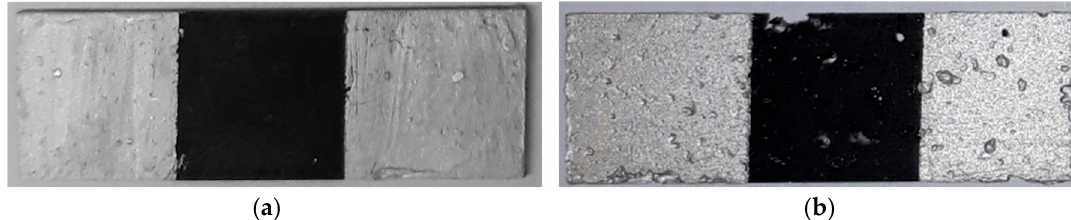
Figure 7. Composite specimens (30 mm × 10 mm × 0.5 mm), partially covered with silver paste; ( a ) Ep/MWCNT-10% (undoped MWCNTs, representative for all undoped specimens) with less and smaller pores; ( b ) nitrogen doped MWCNTs Ep/N-MWCNT1.45-5% (1.45 wt. % N of CNT) with larger and more pores (exemplary for all undoped specimen).